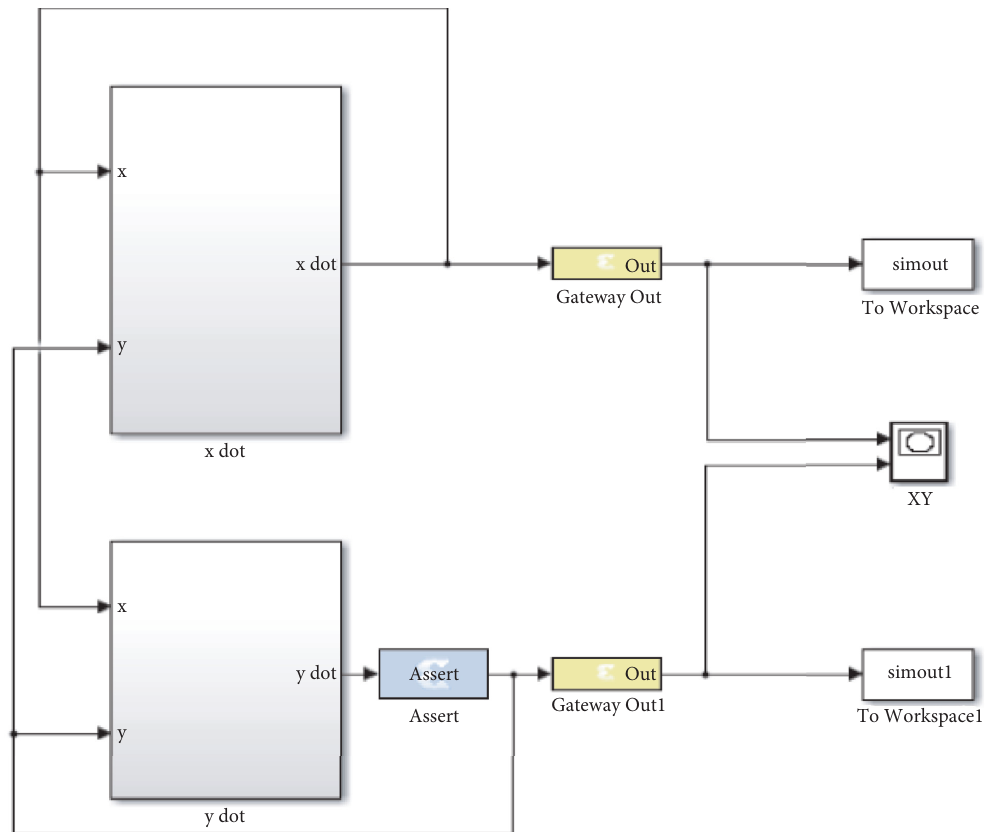
Figure 5: Xilinx system generator (XSG) Simulink diagram of System (1). It is another representation of the proposed system in au- tonomous form.